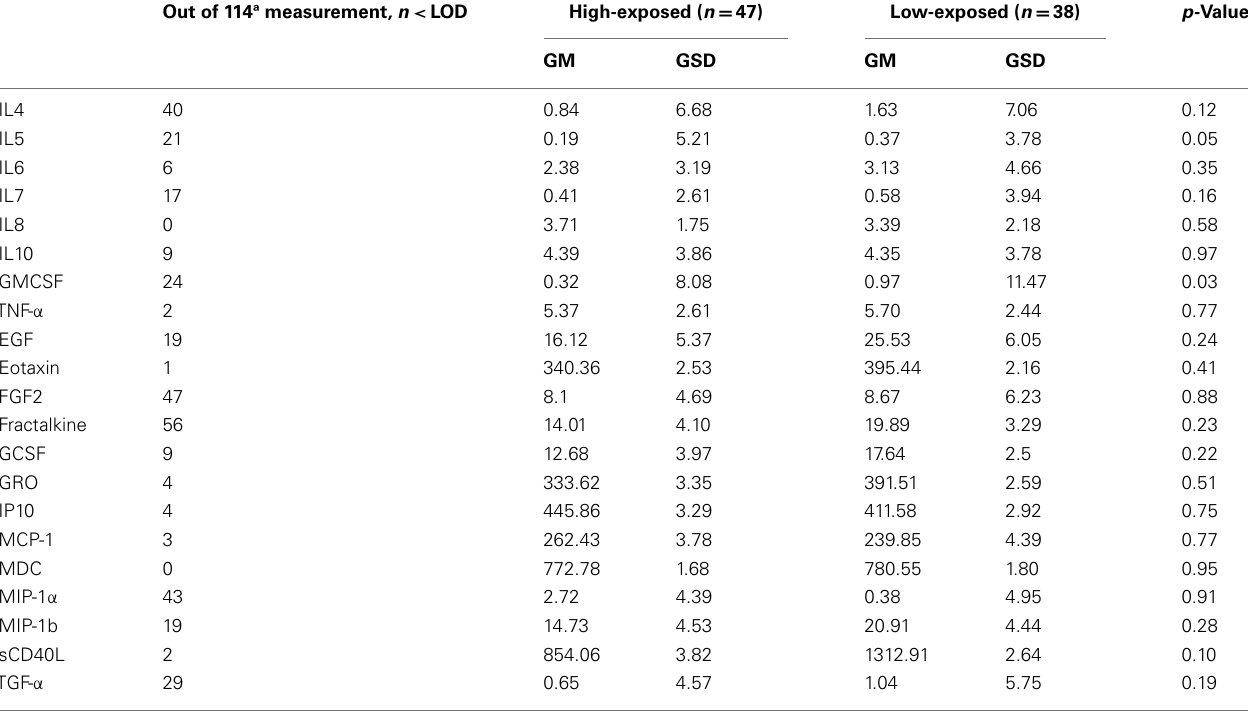
Table 2 | Plasma cytokines concentrations among high and lowTCDD exposed workers ( n = 85). Out of 114ª measurement, n < LOD High-exposed ( n = 47) Low-exposed ( n =